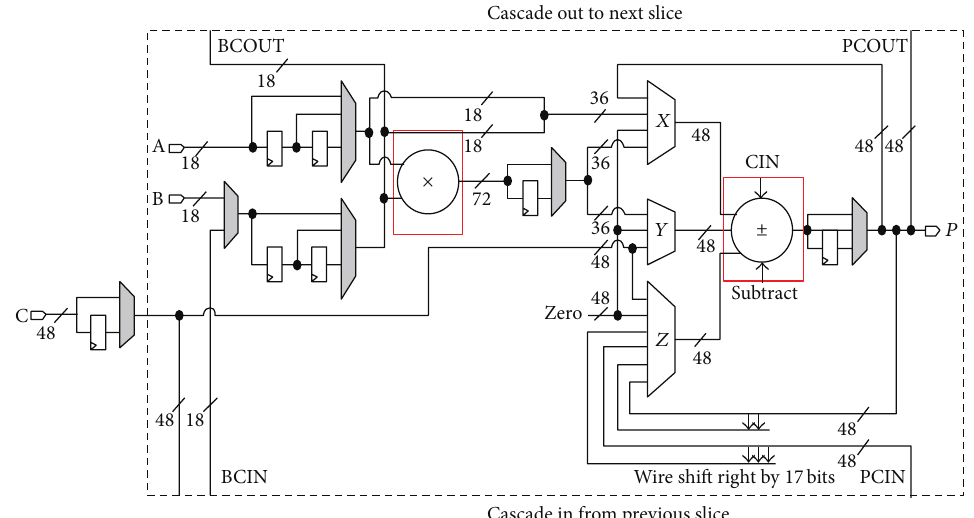
Figure 2: DSP48 architecture in Xilinx Virtex-4